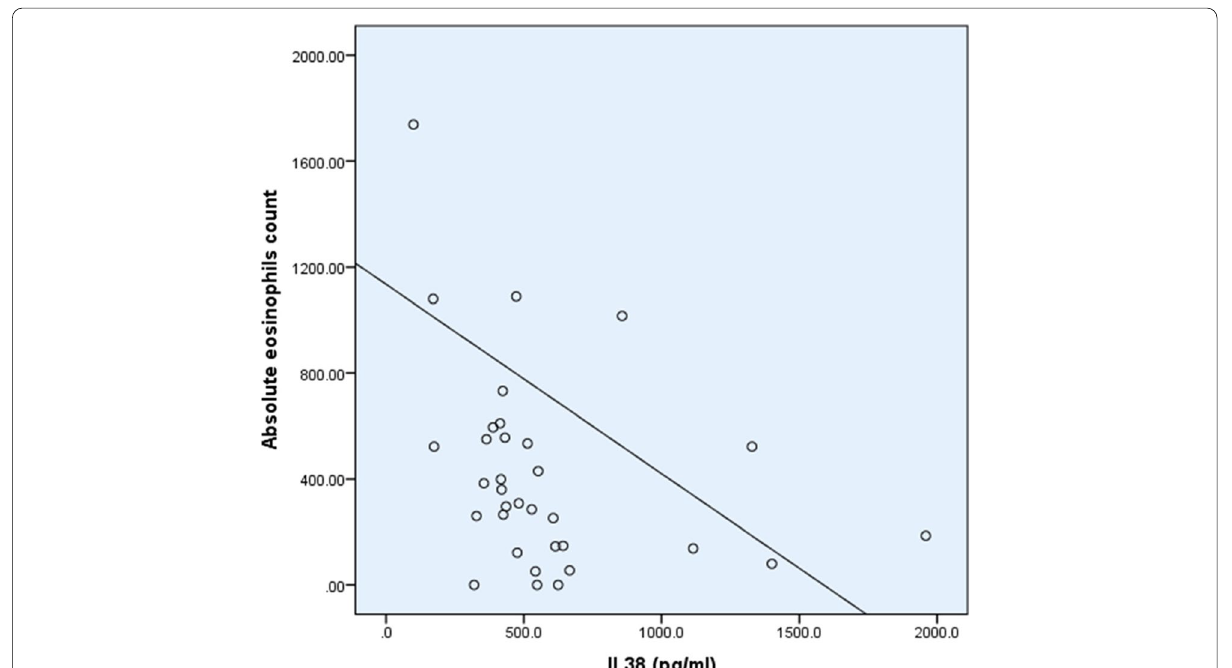
Fig. 4 Correlation between total blood eosinophilic counts and IL-38 serum levels in atopic asthmatic patients